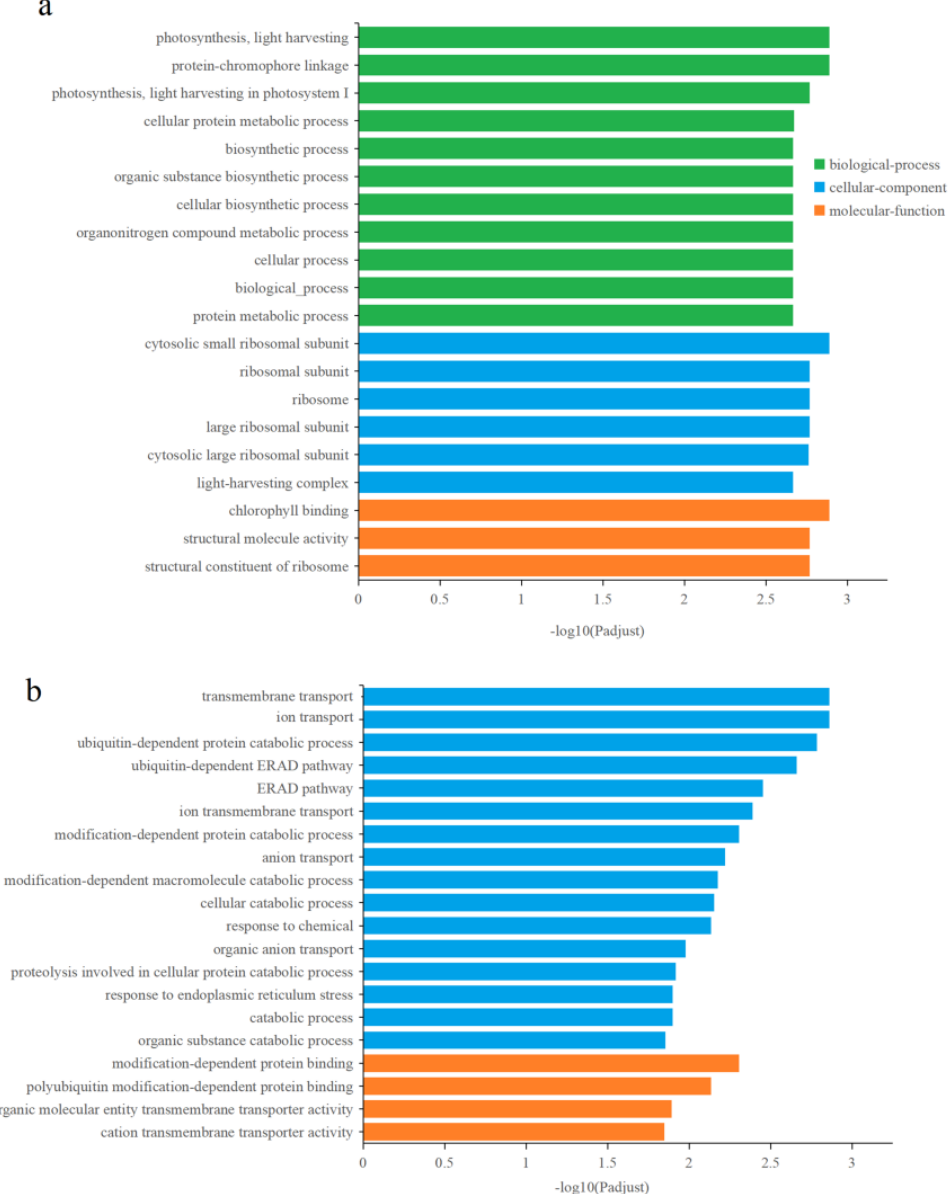
Table 2. DEGs involved in heavy metal stress response in P. tricornutum under Zn 2+ . Gene_id fc